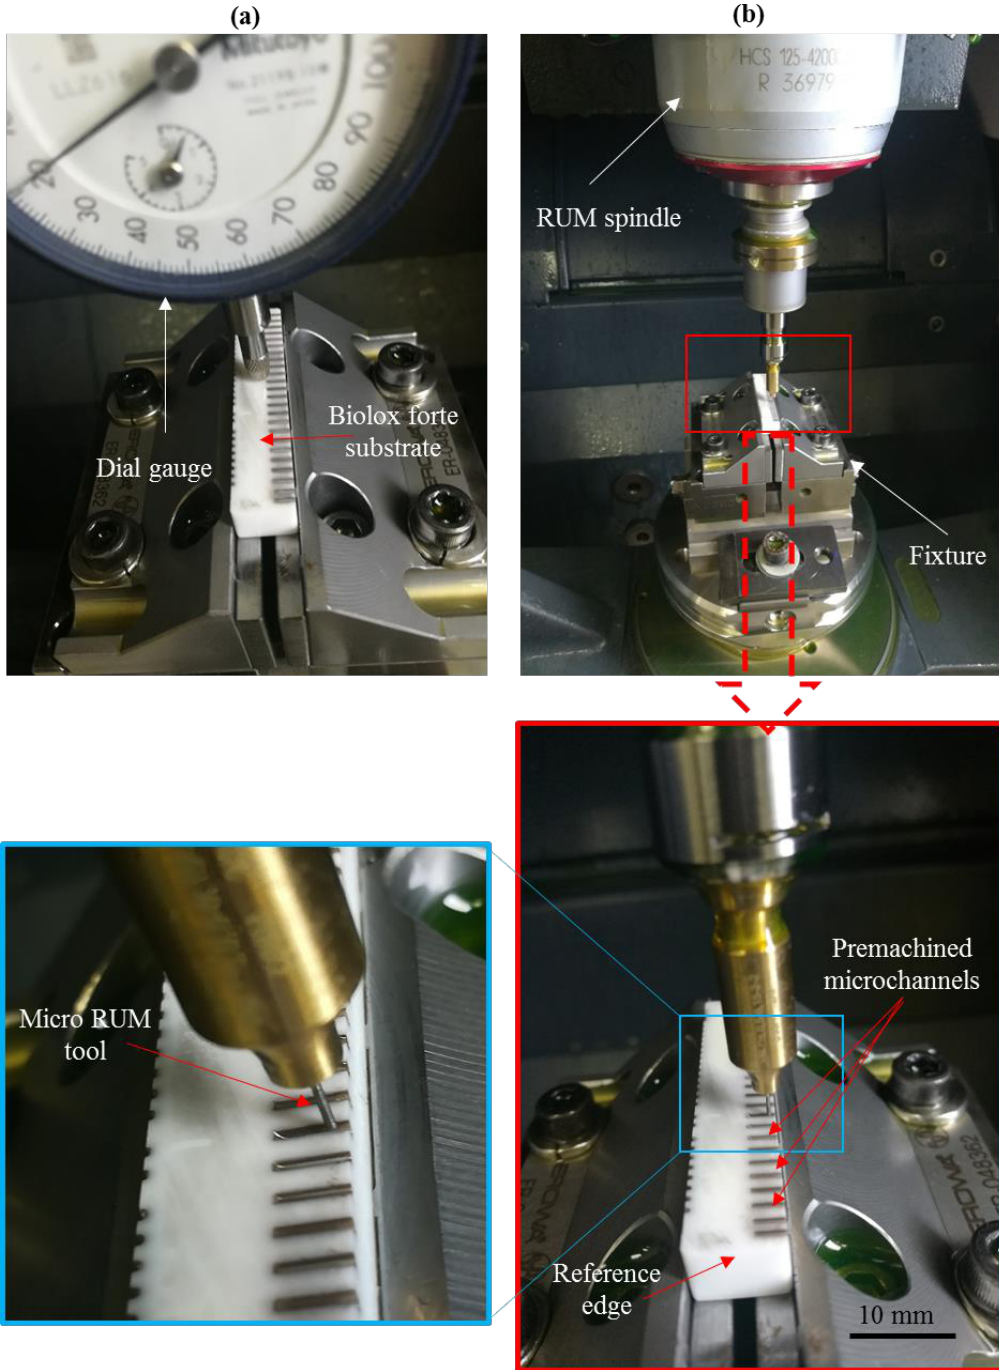
Figure 6. LRUM setup: ( a ) setup of workpiece leveling, ( b ) setup of tool alignment.